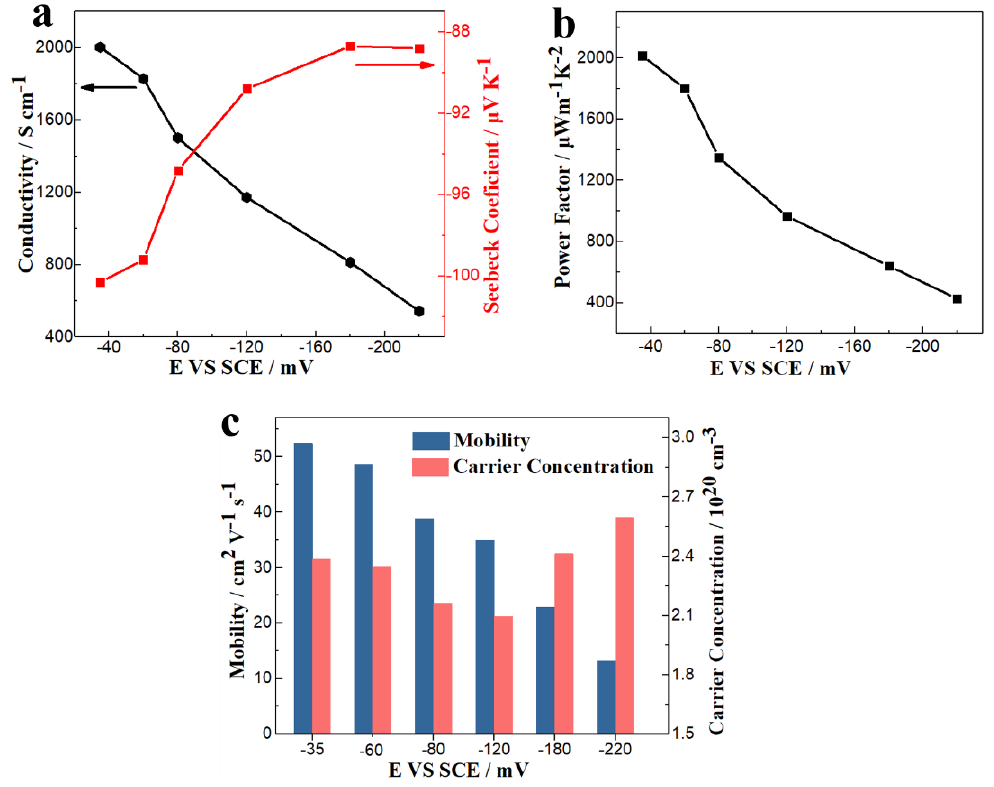
Figure 7. ( a ) Electrical conductivities and Seebeck coefficients, ( b ) power factors; ( c ) carrier Figure 7. ( a )ElectricalconductivitiesandSeebeckcoefficients, ( b )powerfactors; ( c )carrierconcentrations concentrations and mobilities of thin films deposited at different potentials at room temperature. and mobilities of thin films deposited at different potentials at room